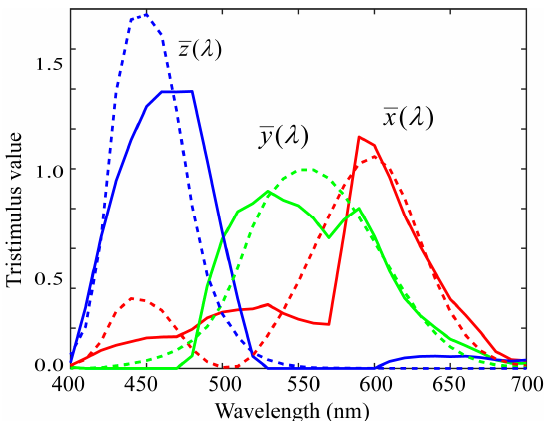
Figure 5. Fitting results to the color-matching functions based on the spectral sensitivity functions of iPhone 8.